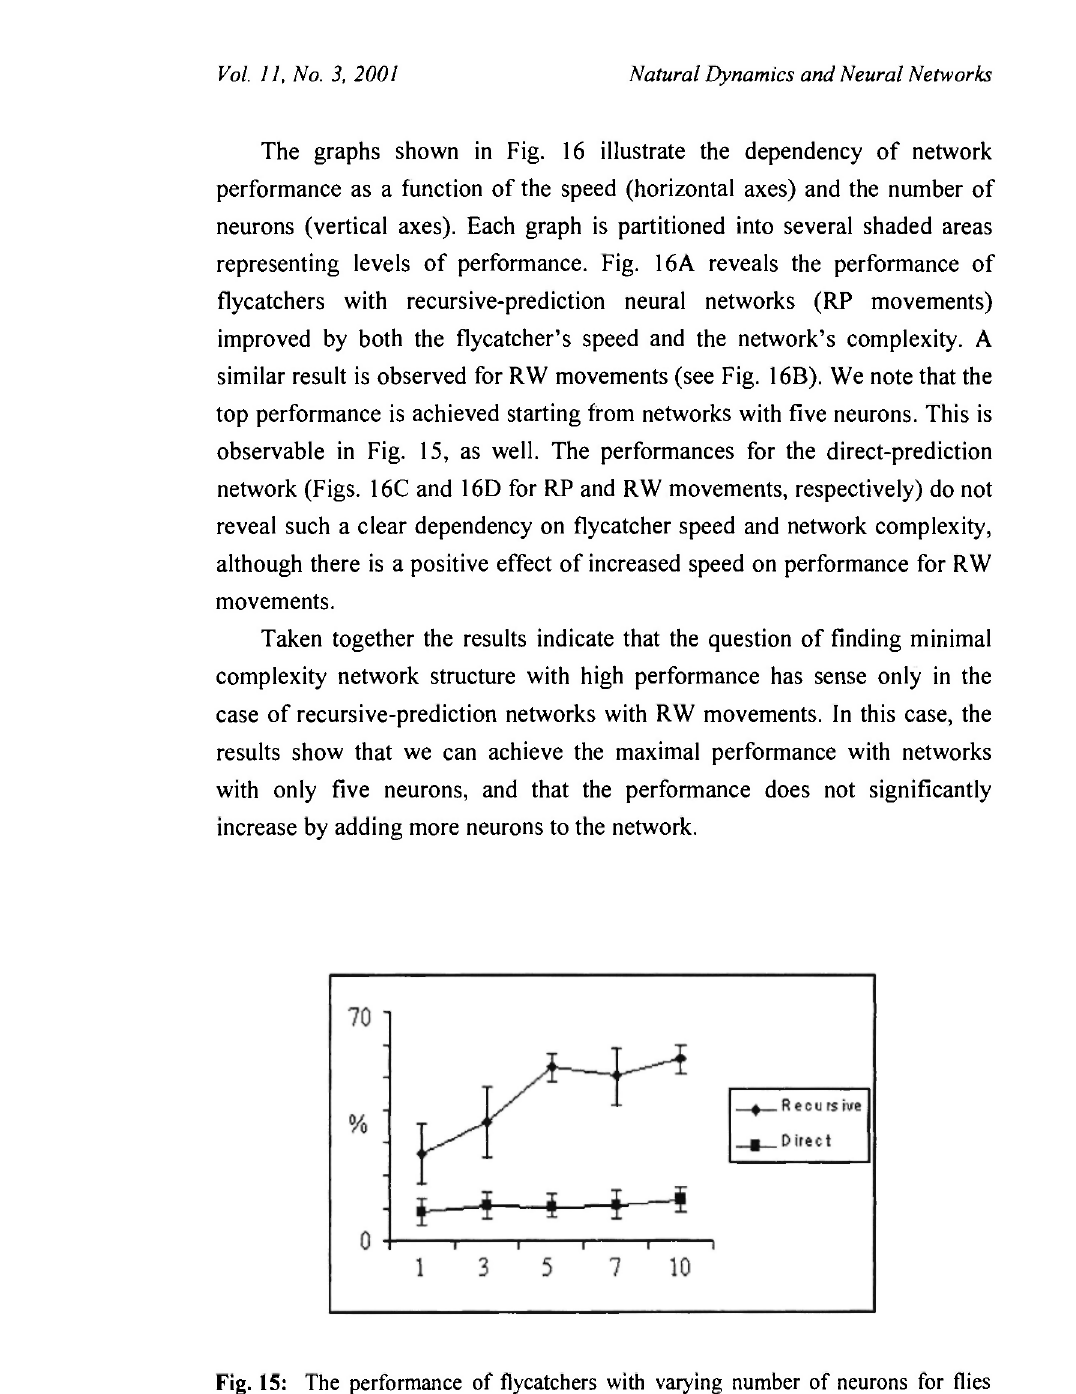
Fig. 15: The performance of flycatchers with varying number of neurons for flies with RW movements, flycatcher speed =